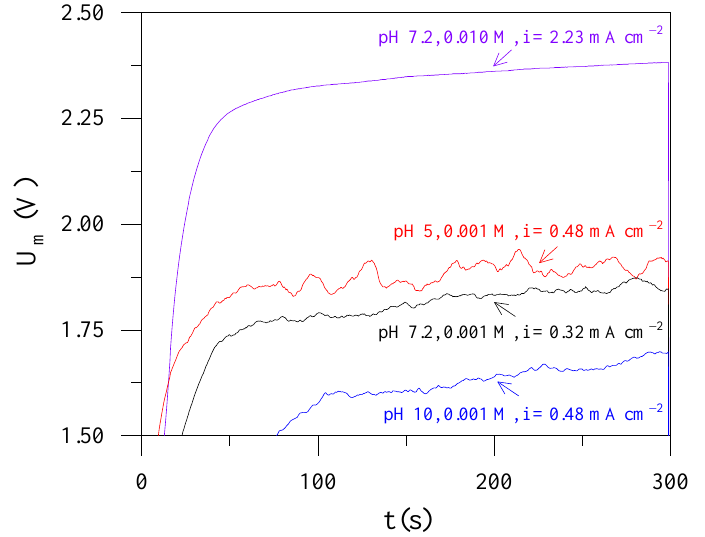
Figure 9. Overlimiting current density condition section of chronopotentiometric curves for different experimental conditions.